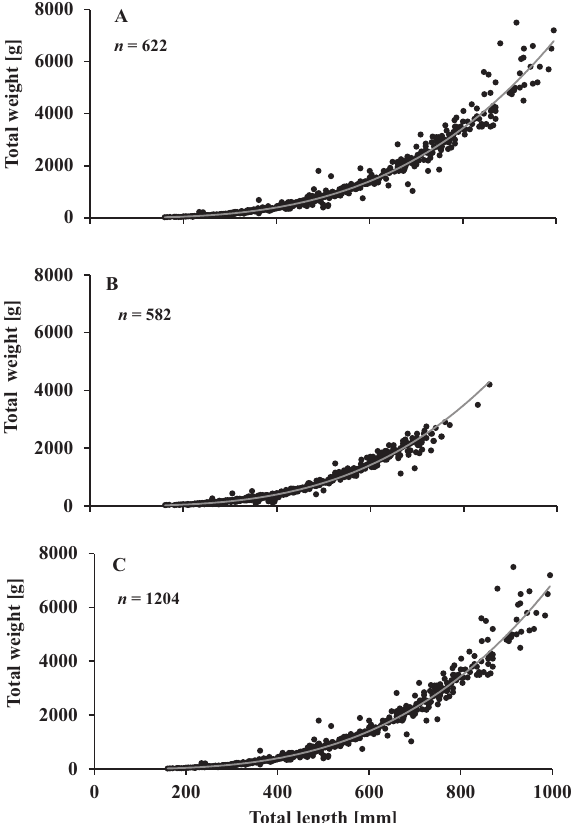
Figure 4. Total length–total weight relation of Pacific hake, Merluccius productus , in the Gulf of California ( A ) females, ( B ) males, ( C ) both